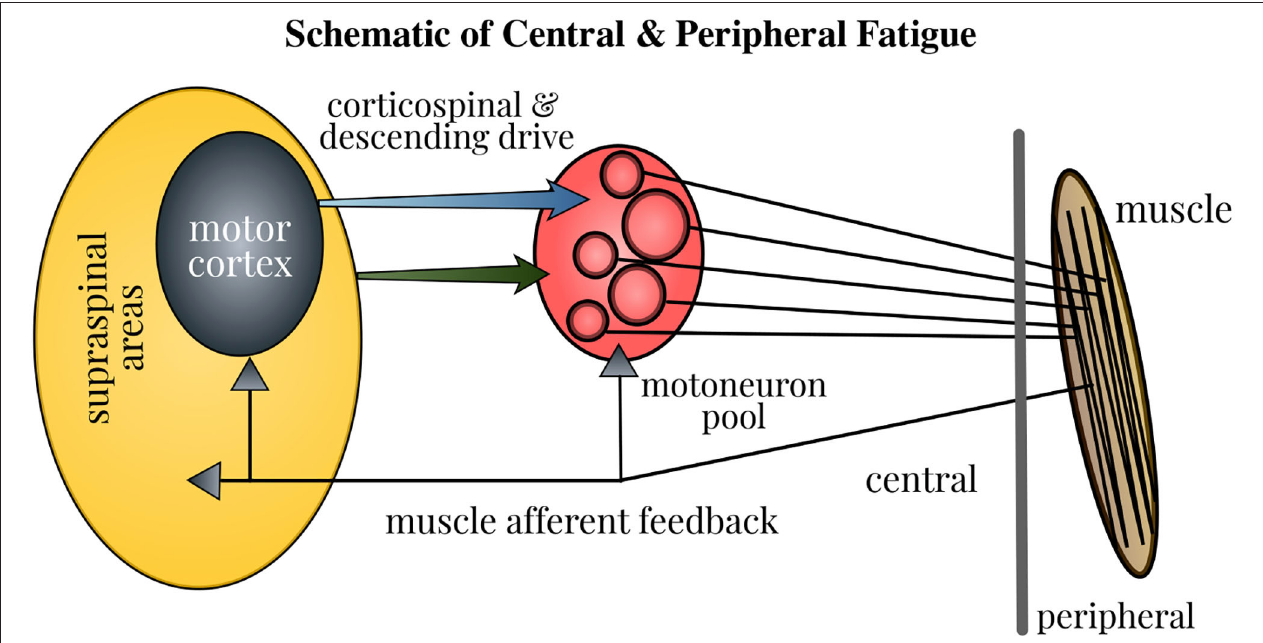
FIGURE 1 | Schematic of neural contributions to muscle fatigue in single-joint contractions. Motoneuron firing is affected by the properties of motoneurons, muscle afferent feedback, and the corticospinal and other descending drive. Fatigue induces changes at all these levels, thus influencing the strength and timing of muscle contractions. Accordingly, the force generated by contraction of muscle fibers in the neuromuscular pathway is modified. Figure courtesy of Taylor et al.